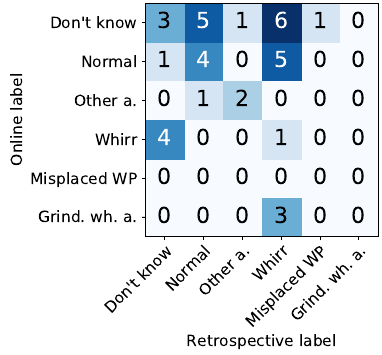
Figure 12. Quantitative comparison of online label feedback and retrospective label feedback (cf. Assumption 3b). Similar to the qualitative evaluation in Figure 10, small agreement between online label feedback and retrospective annotations occurs (i.e., most elements are not situated on the main diagonal of the confusion